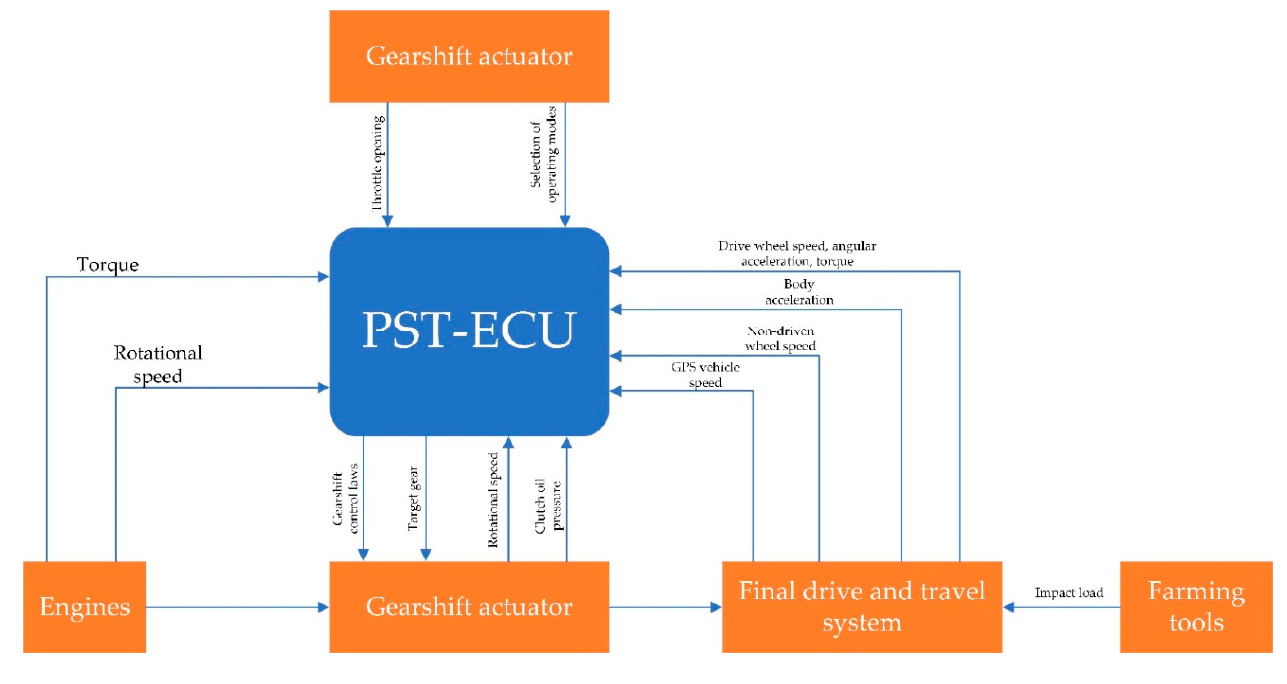
Figure 5. PST control principle.